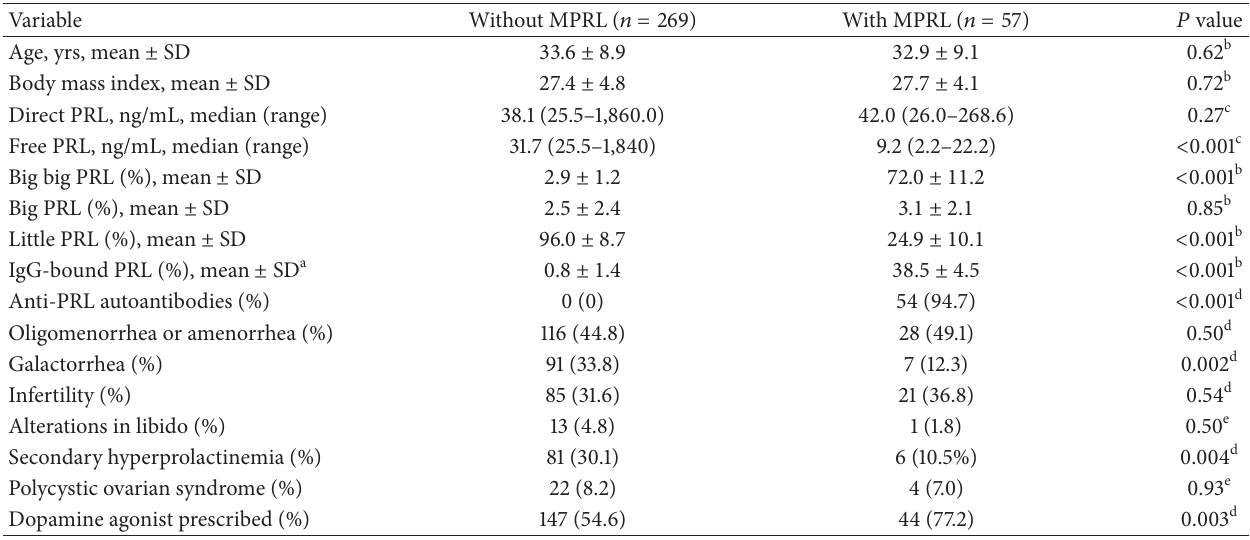
Table 1: Demographic and clinical data, serum total and free immunoreactive prolactin (PRL) levels, distribution of PRL immunoreactivity in three fractions obtained after gel filtration, and percentage of retained PRL in affinity chromatography in hyperprolactinemic patients according to the absence or presence of macroprolactinemia